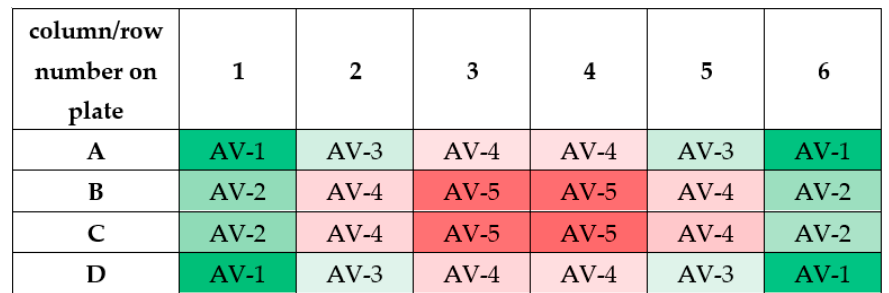
Figure 12. The measured values of the magnetic induction in the wells of 24-well culture plates for f = 30 Hz ( a ) and f = 50 Hz ( b ). All values are given in militesla (mT). Differneces in magnetic induction repersented by different colors: the weakest magnetic iduction–dark red; weak magnetic induction–light red; moderate magnetic indcution–light green; the highest magnetic induction–dark green.